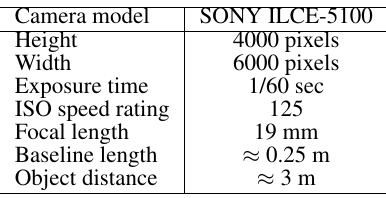
epipolar image and the generated disparity map are shown in Figure 3. The color bar below is in units of pixels. From the color blue to red, the object distance is